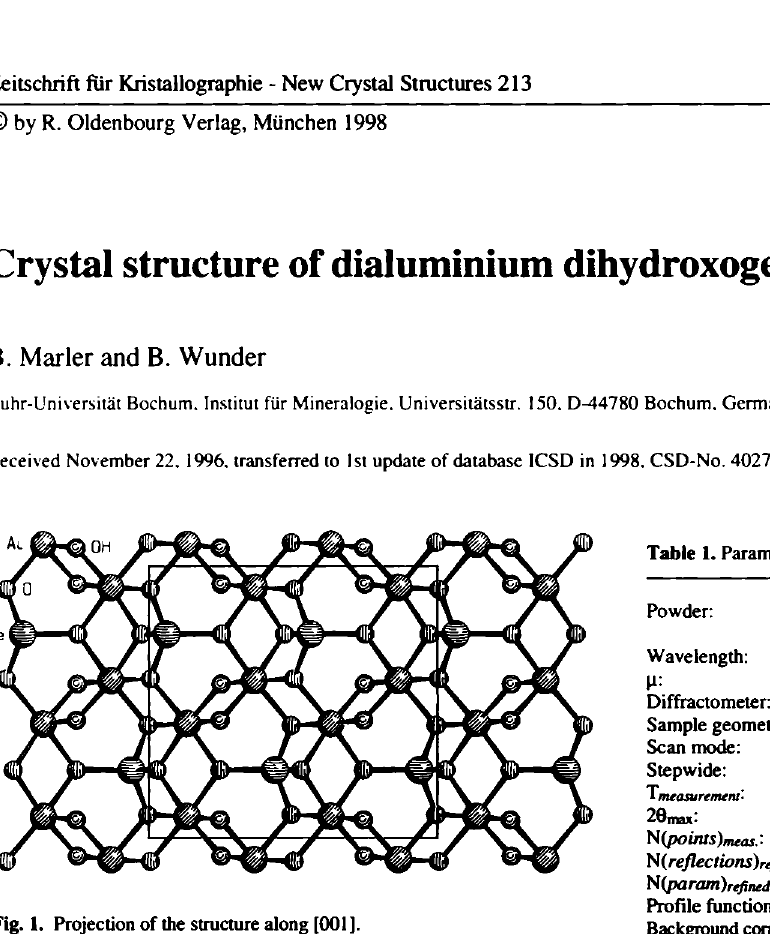
Fig. 1. Projection of the structure along [001]. Source of material: The title compound was synthesized from a mixture of γ-Αΐ2θ3 (prepared from Al-band, Merck 1057,99.87 % purity) and GeOa (α-quartz type, Schuchardt 24249,99.999% purity) in a molar ratio of 1:1.30 wt% of water were added to the oxides and the resulting mixture was sealed in an Au capsule. The